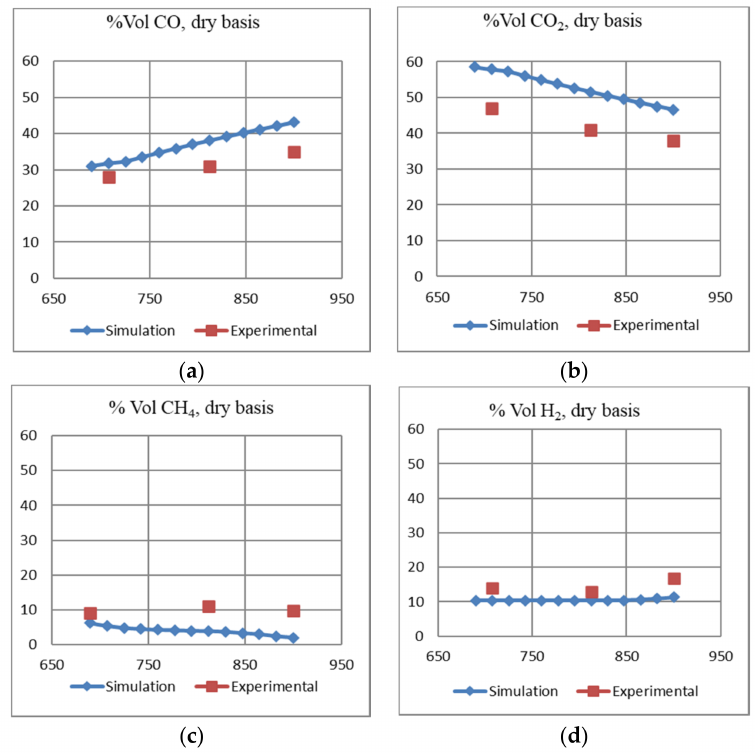
Figure 2. Comparison of simulated and experimental data: effect of air gasification temperature on syngas composition: ( a ) CO; ( b ) CO 2 ; ( c ) CH 4 ; and ( d ) H 2